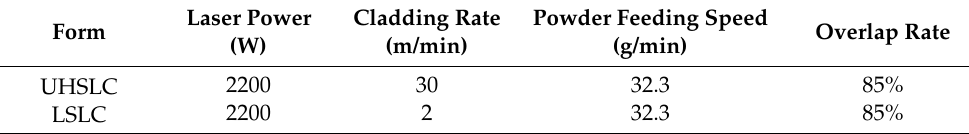
Table 2. Processing parameters for Inconel625 alloys coatings prepared by UHSLC and